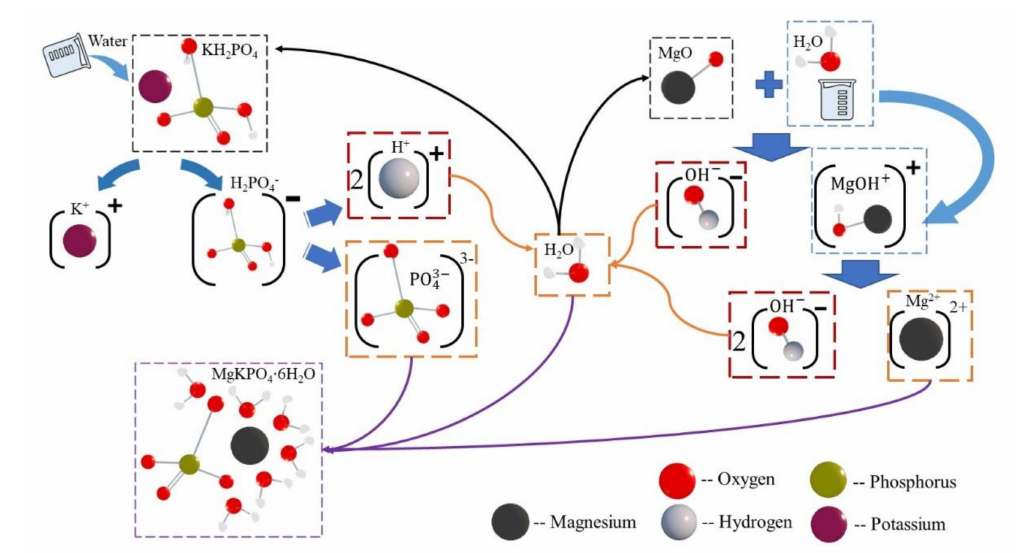
Figure 14. Hydration process of